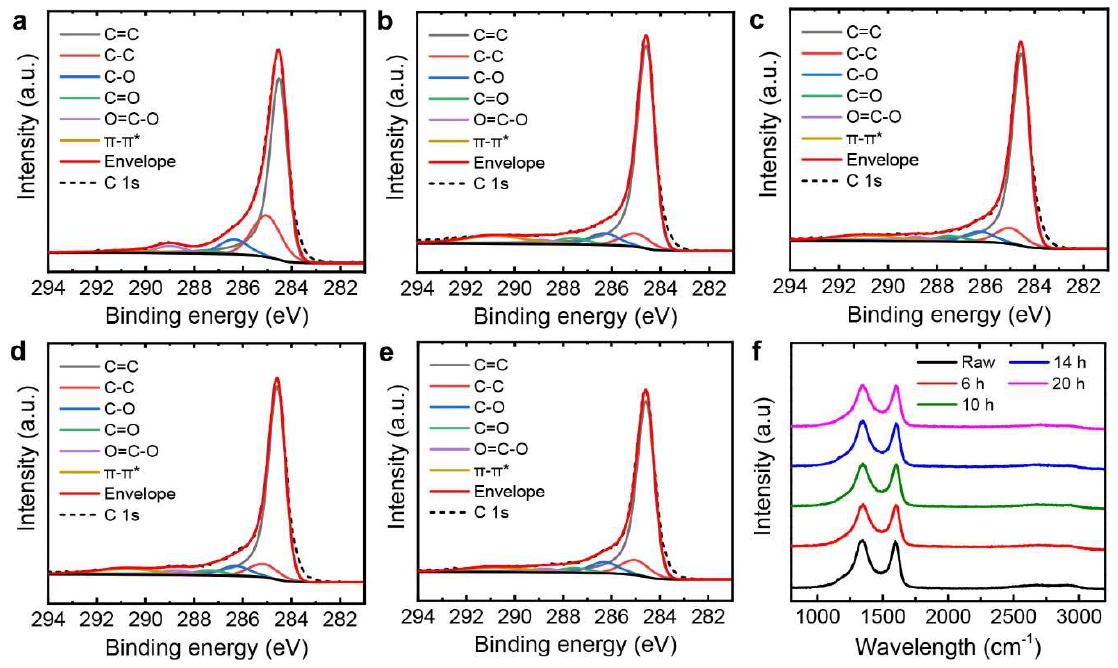
Figure 5. ( a – e ) C 1s core-level X-ray photoelectron spectroscopy (XPS) spectra of rGO papers; sonication times are ( a ) 0, ( b ) 6, ( c ) 10, ( d ) 14, and ( e ) 20 h. ( f ) Raman spectra of rGO papers before and after sonication treatments.